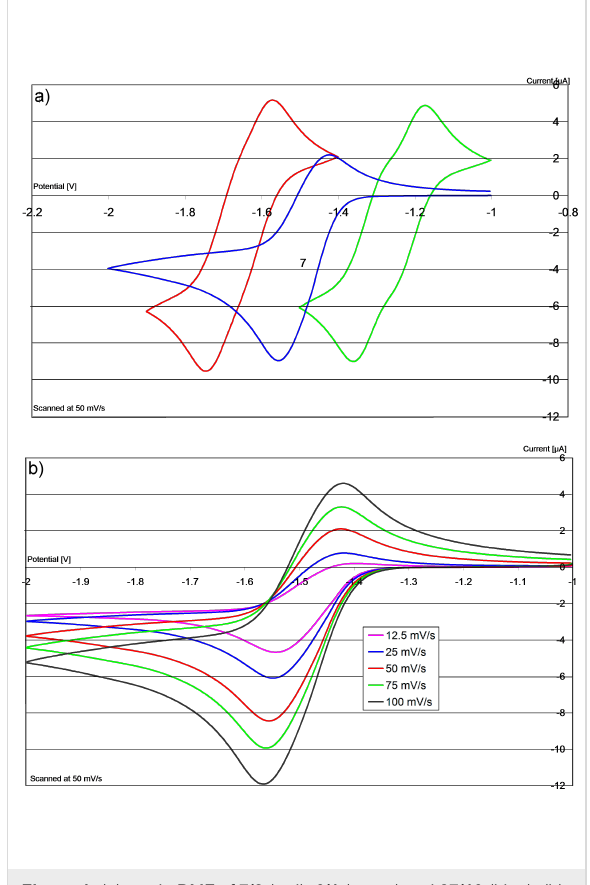
Figure 4: (a) c.v. in DMF of 7/2 (red), 6/1 (green) and 27/10 (blue); (b) c.v. in DMF of 27/10 at different scan rates. Current plotted vs V rela- tive to Fc/Fc +